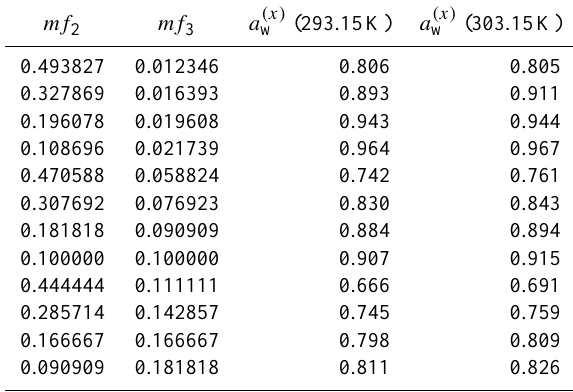
Table A12. Bulk water activity measurements of the system wa- ter (1)+malonic acid (2)+LiNO 3 (3) at T = 293 . 15 and 303 . 15K. Aqueous solution compositions are given in mass fractions ( mf j ).